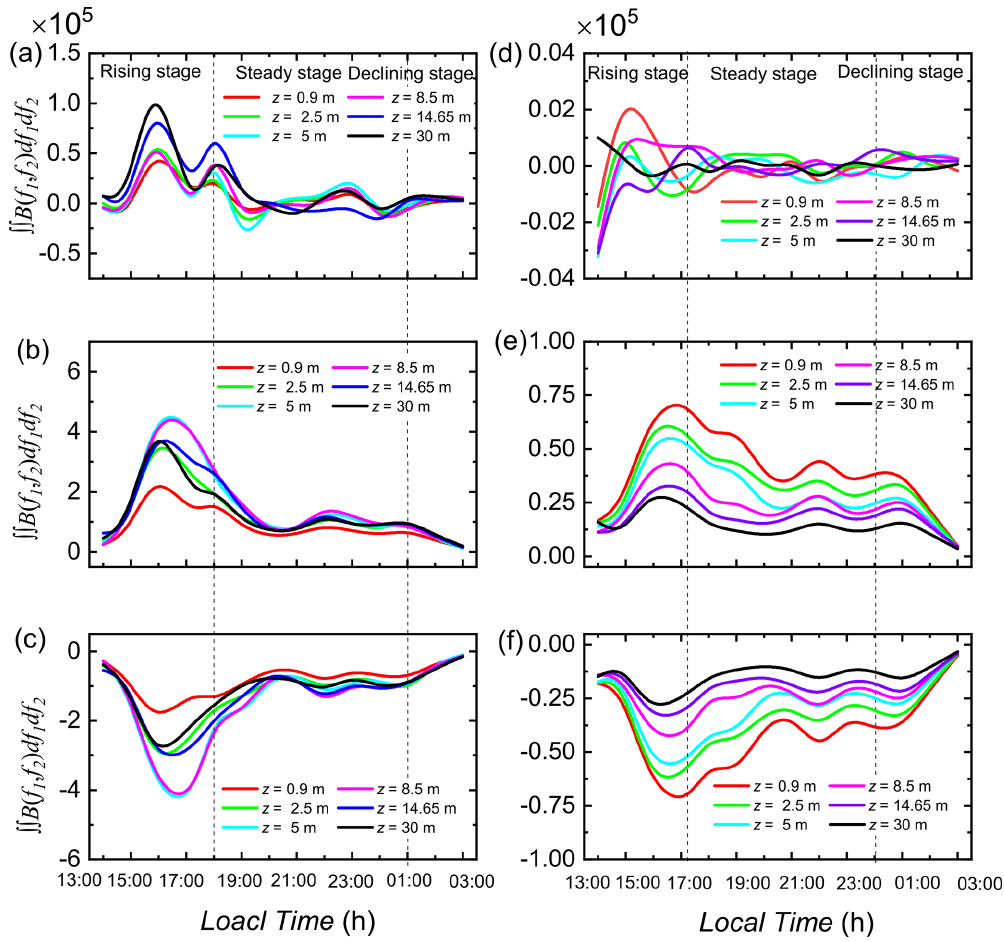
Figure 8. Evolution of the total integral bispectra. (a–c) Evolution of the total integral bispectra for LSMs and VLSMs at different heights: (a) the overall bispectra integrals; (b) positive and (c) negative bispectra integrals. (d–f) Evolution of the total integral bispectra for small-scale motions ( λ < 0 . 3 δ , Wang and Zheng, 2016) at different heights, where the settings of (d) – (f) are similar to those of (a) – (c)